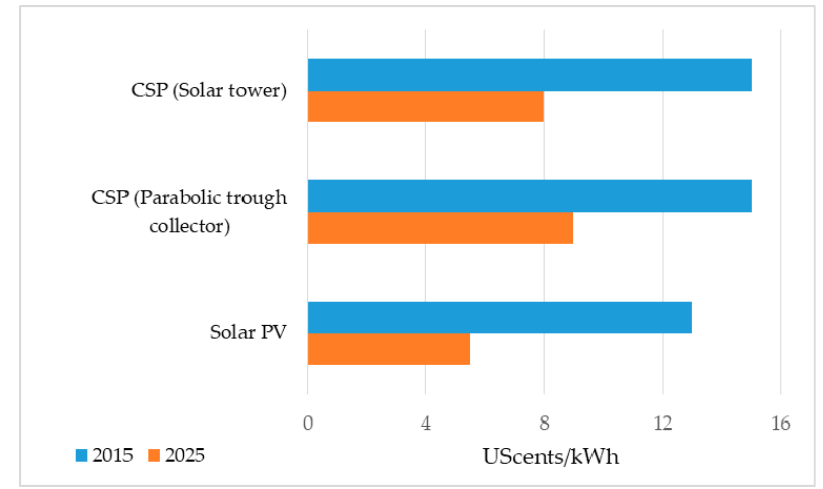
Figure 20. Comparison of global weighted average LCOE between 2015 and 2025